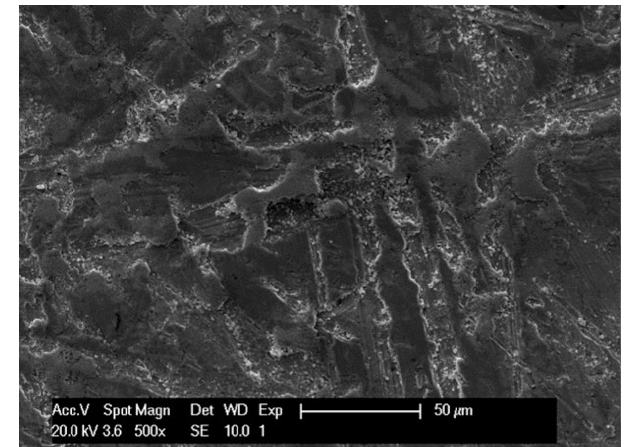
Figure 6. Example of pulse-echo A-scan (relative pulse-echo am- plitude vs. time) of low-temperature sintered sample. Notice the large amount of signals produced by the transducer. The receiver gain was at 40dB. The vertical axis is relative amplitude, which depends on both the transmitter and receiver electronics. The im- portant feature to notice is the high signal-to-noise level.